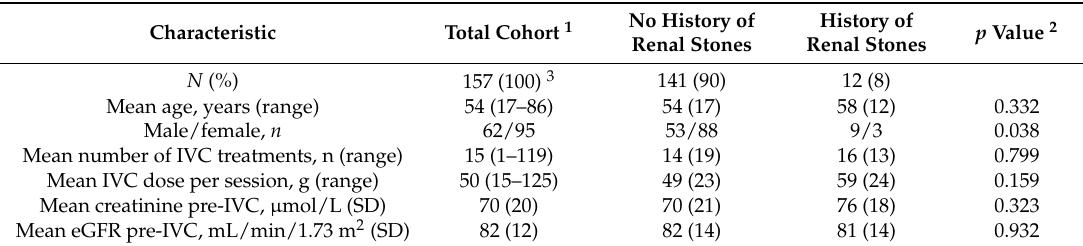
Table 1. Characteristics of participants.